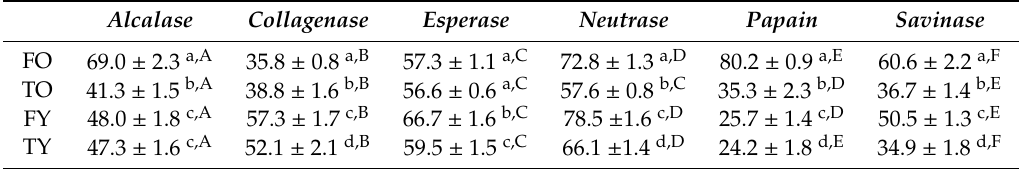
Table 3. DPPH • inhibition (%) per mg of peptides, at 80 ◦ C. FO = old femur, 10 years; TO = old tibia, Table 3. DPPH• inhibition (%) per mg of peptides, at 80 °C. FO = old femur, 10 years; TO = old tibia, 10 years; FY = young femur, 4.5 years; TY = young tibia, 4.5 years. 10 years; FY = young femur, 4.5 years; TY = young tibia, 4.5 years. Alcalase Collagenase Alcalase Collagenase Esperase Neutrase Papain Savinase